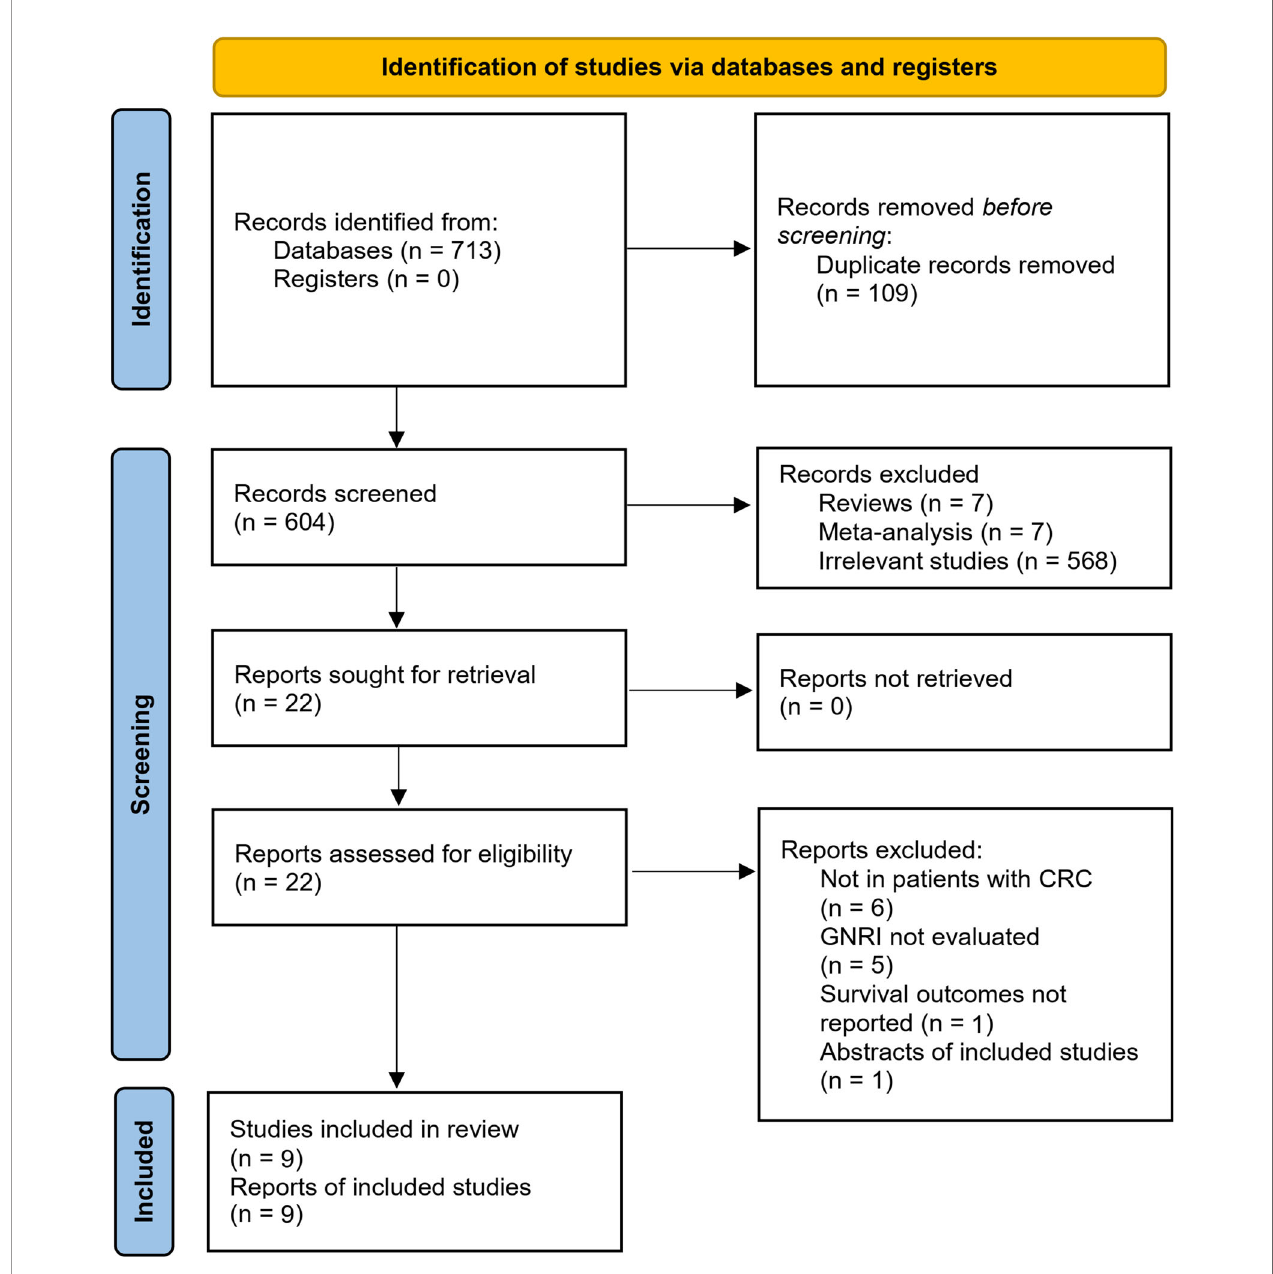
FIGURE 1 | PRISMA 2020 diagram of database search and study